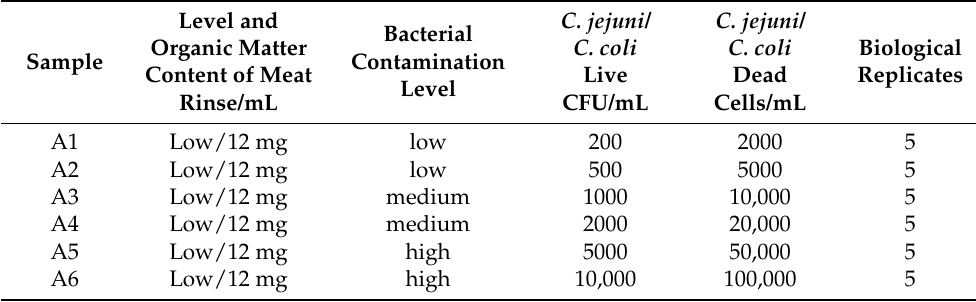
Table 2. Spiking plan for the accuracy study. For each sample (A1 to A6), 3 mL chicken neck skin rinse were spiked with live- and dead-cell standards of C. jejuni and C. coli , respectively, in five biological replicates.